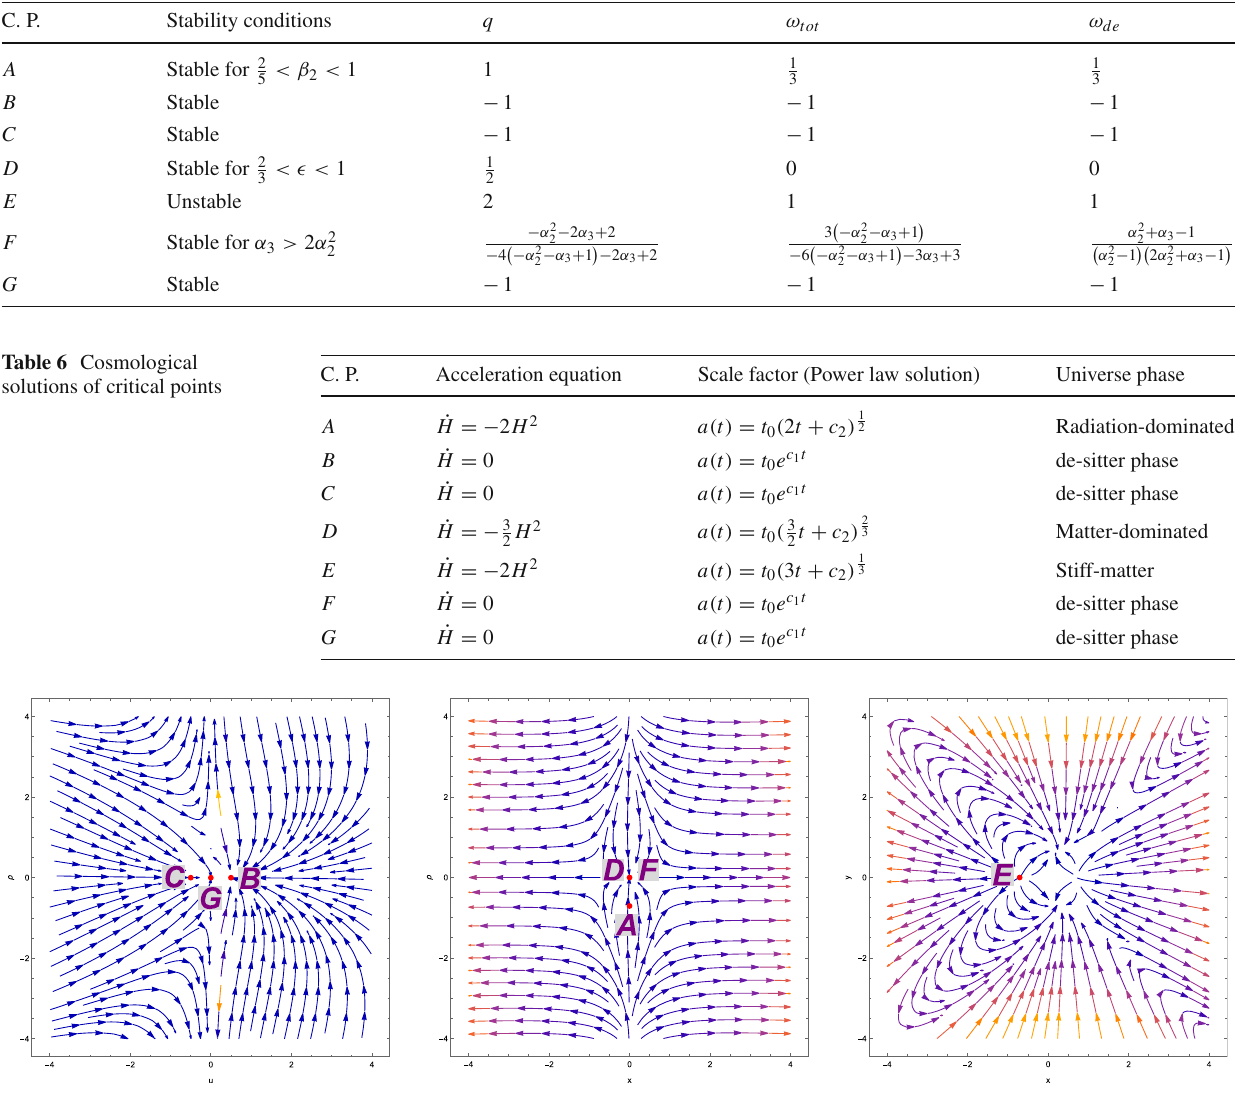
Table 5 Stability conditions, EoS Parameter and deceleration parameter C. P.